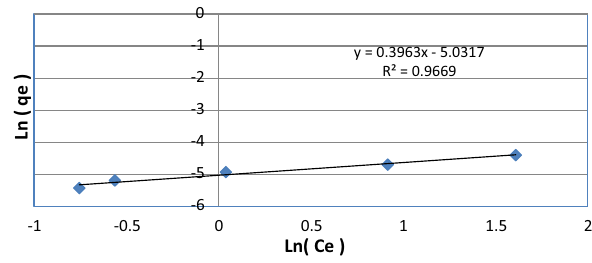
Fig. 9 Ln( q C e ) versus Ln( e ) for Freundlich equation for limestone size (9.5 mm) and C 0 (1.72